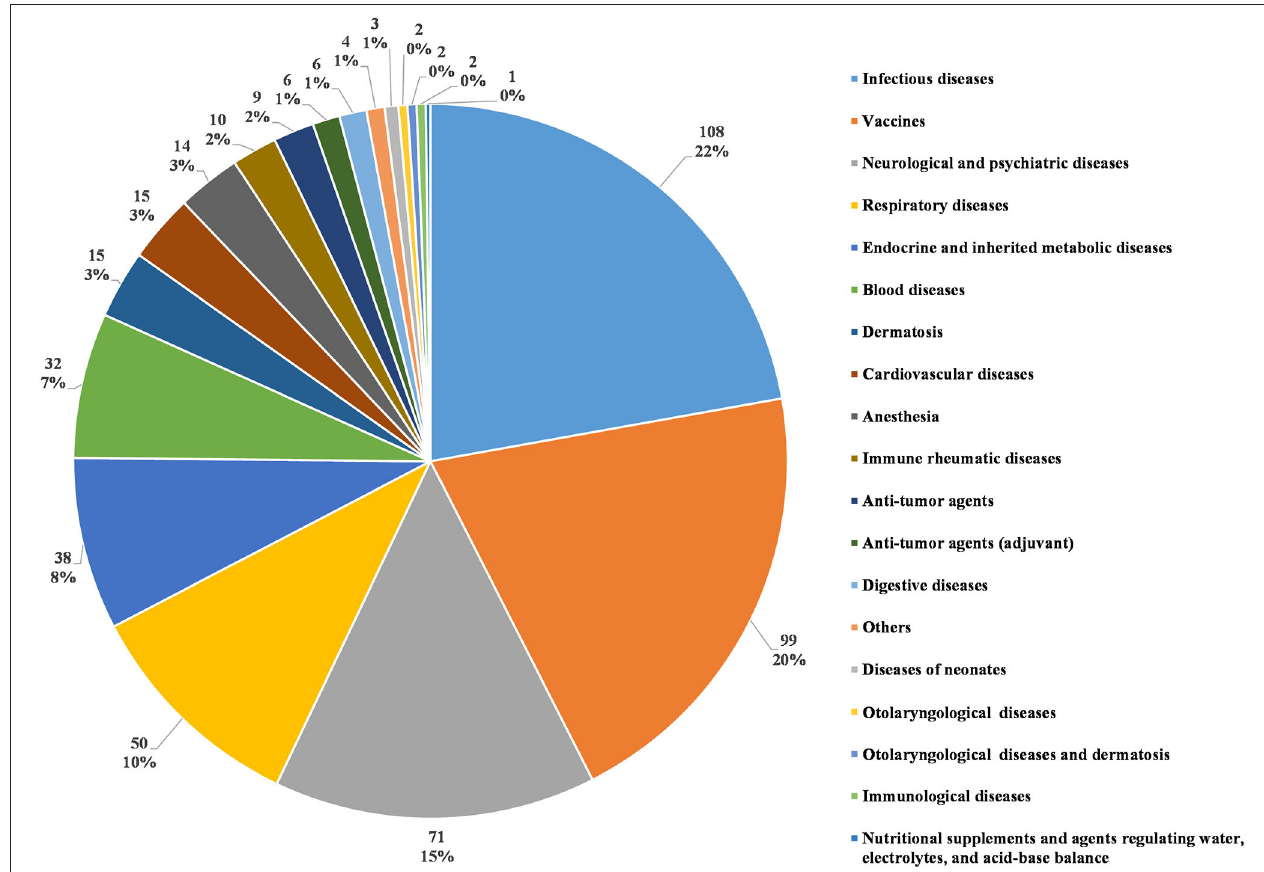
FIGURE 5 | Distribution of pediatric clinical trials by disease